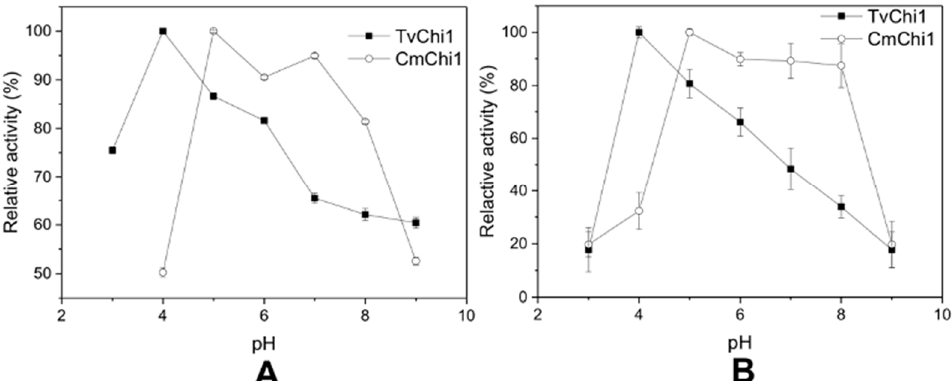
Figure 3. Effect of pH on activity of the TvChi1 and CmChi1. ( A ) The optimal pH for TvChi1 and CmChi1; ( B ) the pH stability for TvChi1 and CmChi1. Data are given as means ± standard deviation, n = 3.